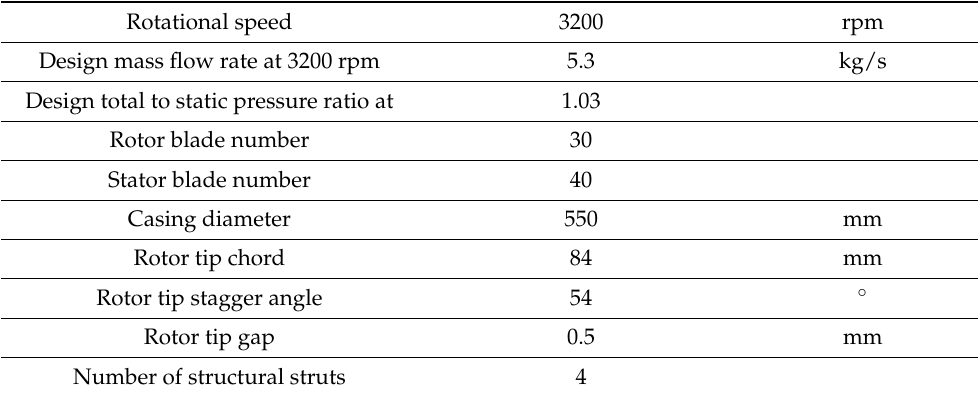
Table 1. Compressor